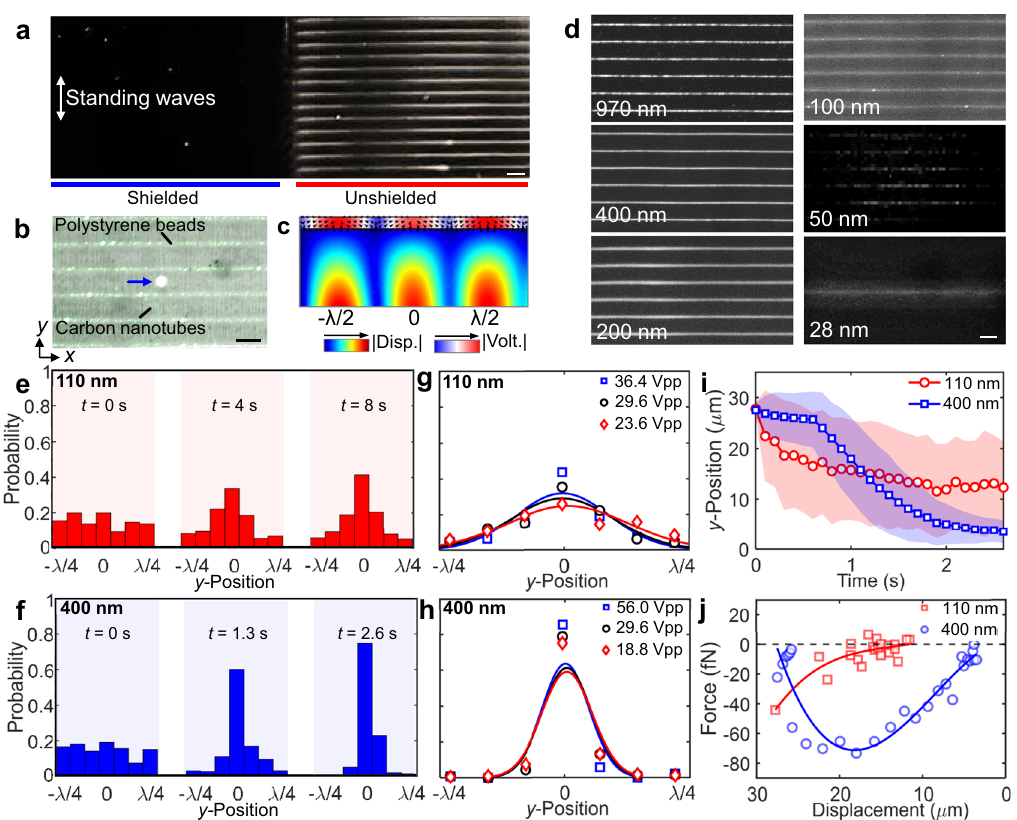
Fig. 2 Nanoparticle manipulation with 1D standing waves. a Patterning of 100 nm diameter fl uorescent polystyrene particles using 1D acoustoelectronic fi elds on a half-shielded piezoelectric substrate. b A stacked composite of images demonstrating the trapping positions of polystyrene nanoparticles (100 and 400 nm beads) and carbon nanotubes. The bright metal dot (blue arrow) indicates the geometric center between two mirrored IDTs with electric connection in trans -mode ( Δ φ 1 = π ), of which the lateral position is aligned with a displacement node. c Simulation indicating the trapping position of 100 nm polystyrene beads in water. The arrow indicates the direction of the acoustoelectronic forces. Disp. substrate displacement, Volt. voltage in the water chamber. d 1D patterns of 28 – 970 nm polystyrene beads. e – j Nanoparticle image velocimetry analysis on 100 and 400 nm particles. e – f Time- elapsed distribution of single nanoparticles near the trapping nodes from − λ /4 to + λ /4. Normal fi tting curves are used. g , h The in fl uences of excitation amplitudes on the nanoparticle distribution. i The average trajectory of single nanoparticles under a 36.4 Vpp excitation amplitude. j The averaged distance-dependent actuation force on single nanoparticles. Scale bars: 60 μ